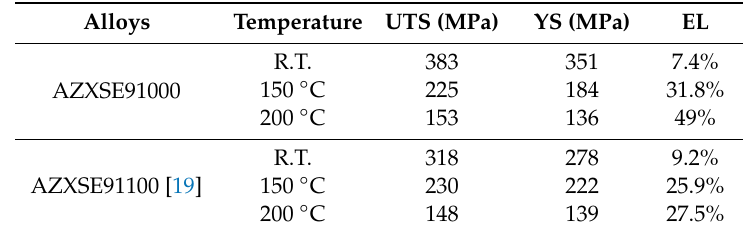
Table 2. Tensile properties of the as-extruded AZXSE91000 and AZXSE91100 alloy.